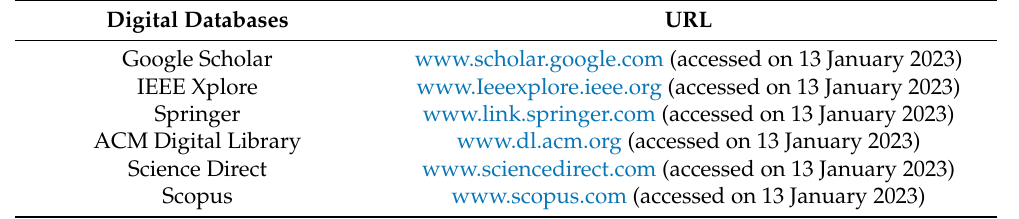
Table 2. Research source databases.